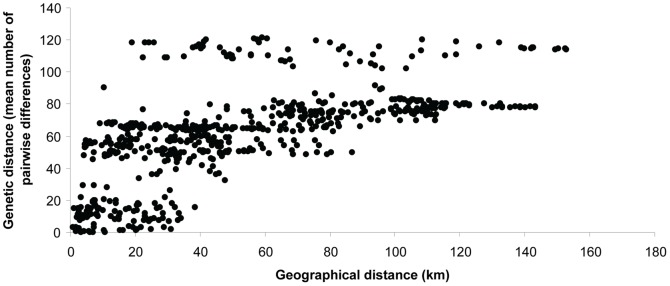
Scatter plots of geographical distances and genetic distances.